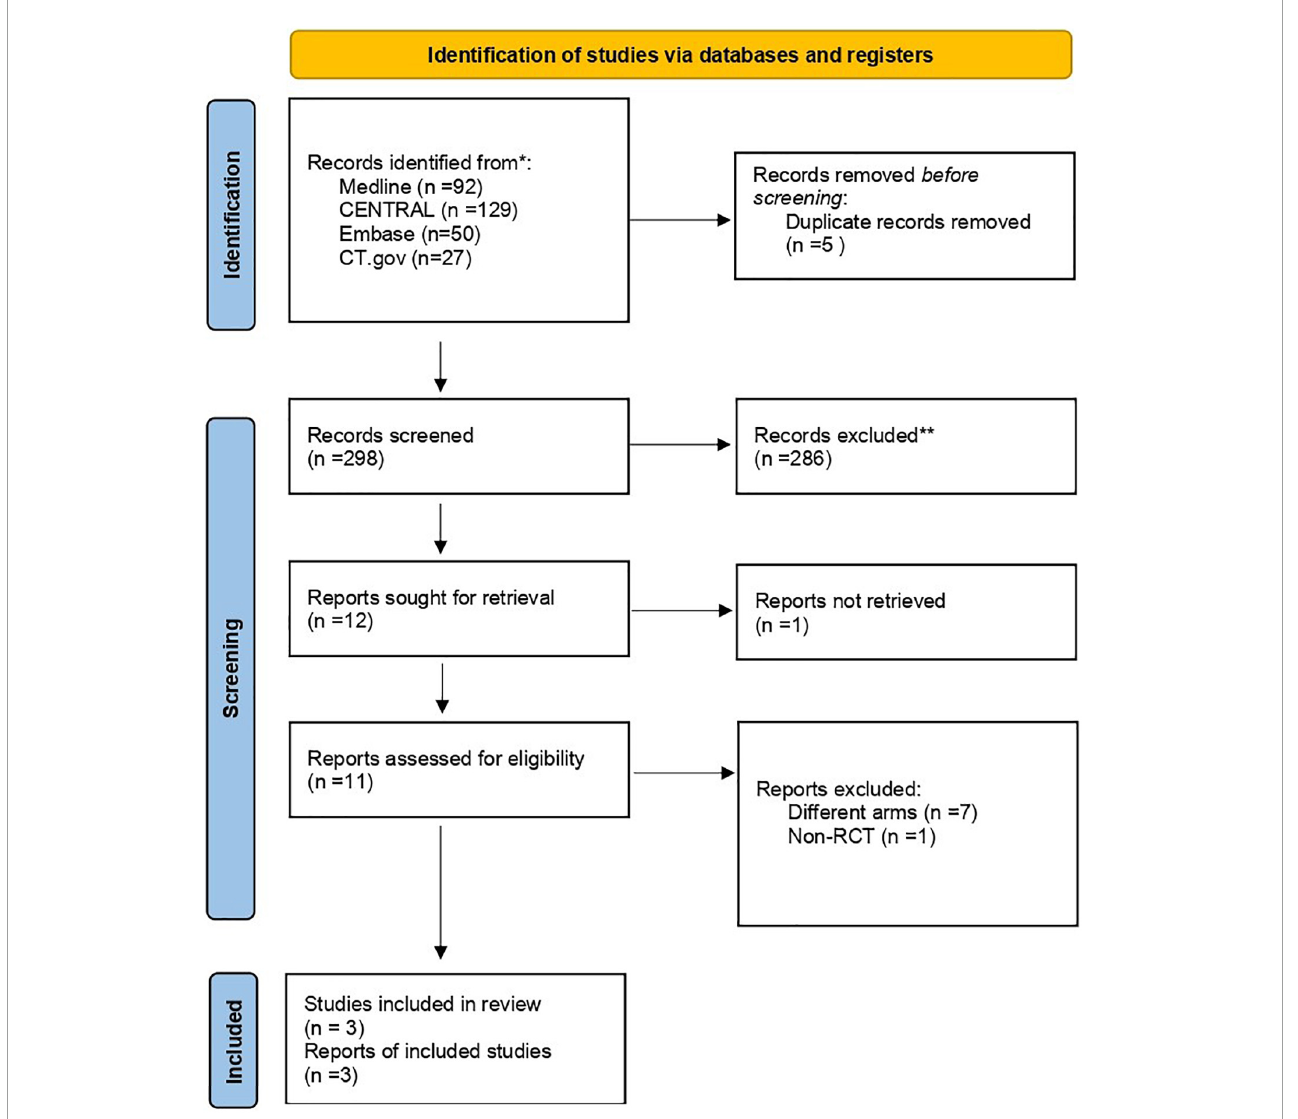
FIGURE1 Study flowchart as per the Preferred Reporting Items for Systematic Reviews and Meta-Analysis (PRISMA) criteria. CENTRAL, Cochrane Central Register of Controlled Trials; RCT, randomized controlled trial. *Search results on October 1, 2022. **Exclusion was done by humans